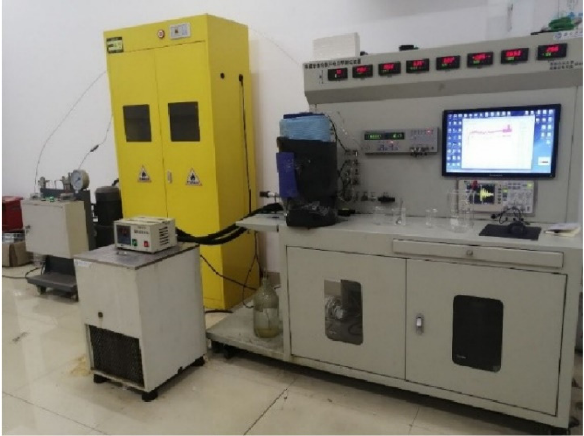
Figure 2. The acoustoelectric and mechanical testing system of hydrate samples.